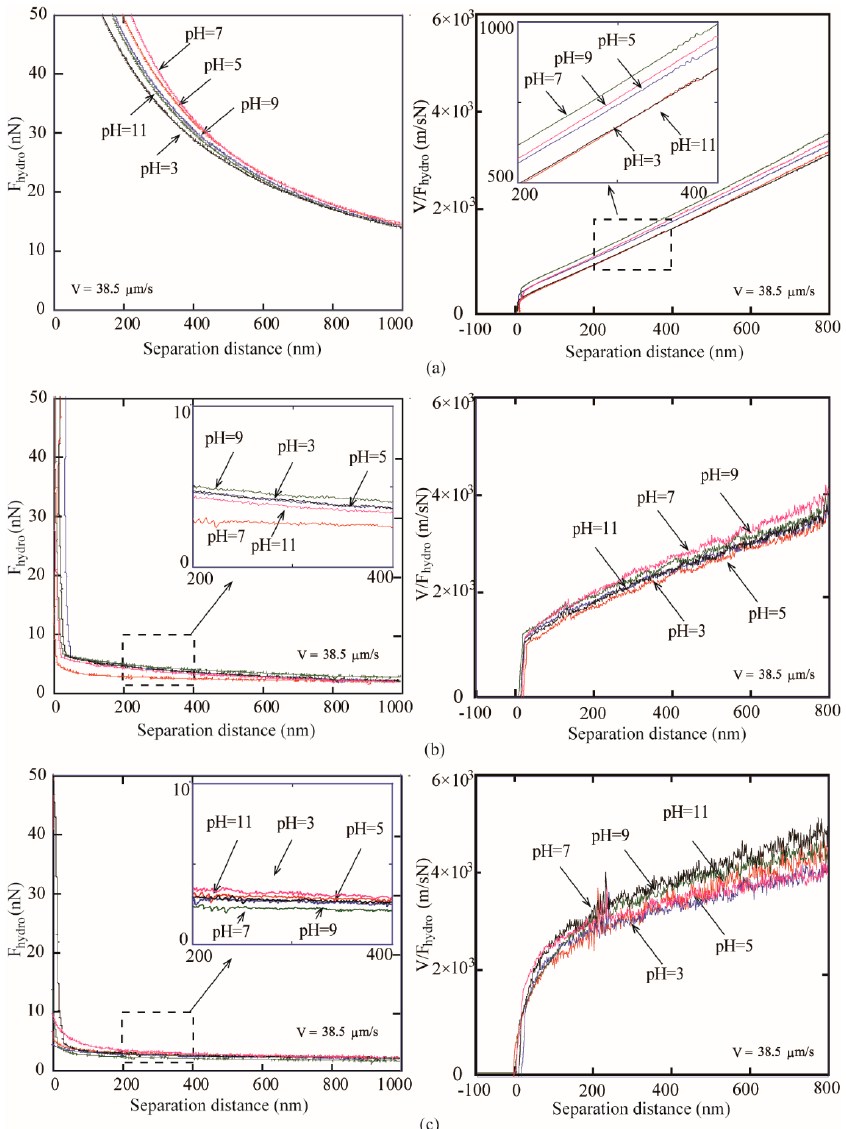
Figure 7. Hydrodynamic force F hydro and V/ Fhydro of sphere on ( a ) superoleophilic, ( b ) oleophobic, and ( c ) superoleophobic surfaces immersed in DI water with different pH values obtained at a sphere velocity of 38.5 μ m/s.